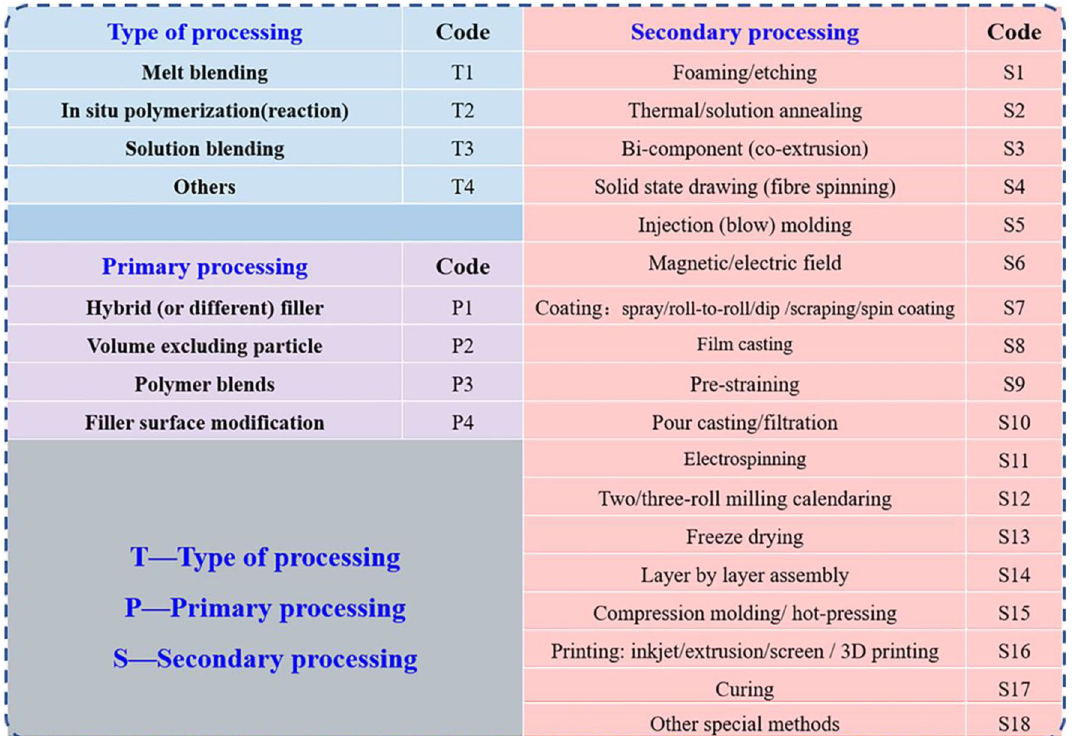
Table 1 “Toolbox”: the type of processing and specific tools used during processing for morphology control. These tools are summarized from 700 literature collected in various FPCs